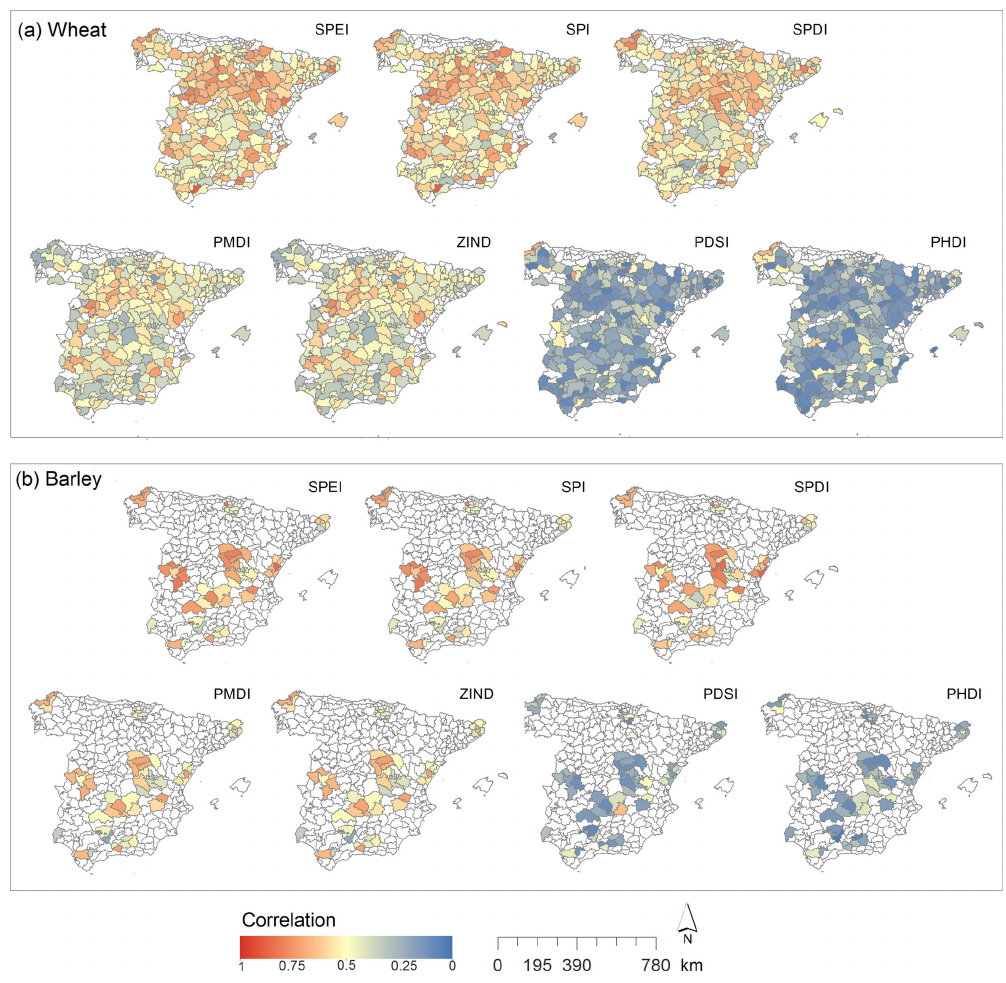
Figure 5. Spatial distribution of the highest correlation coefficients between the drought indices and the wheat (a) and barley (b) yields at the agricultural district scale, independently of the